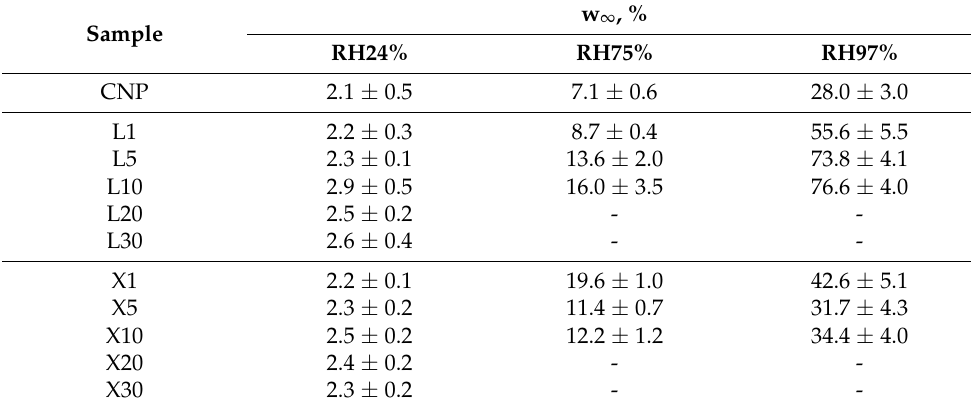
Table 2. The moisture content at saturation for NPs measured at different